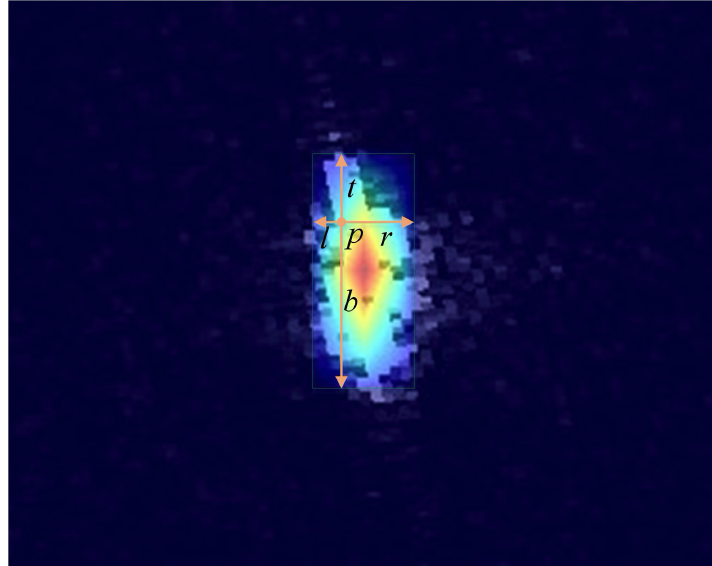
Figure 2. Visualization of